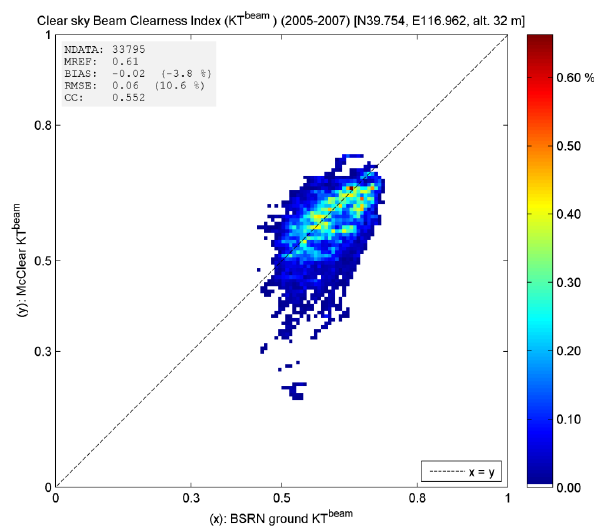
Fig. 9. Scatter density plot between BSRN 1min clear-sky data and McClear. Xianghe. Beam irradiance on horizontal surface.